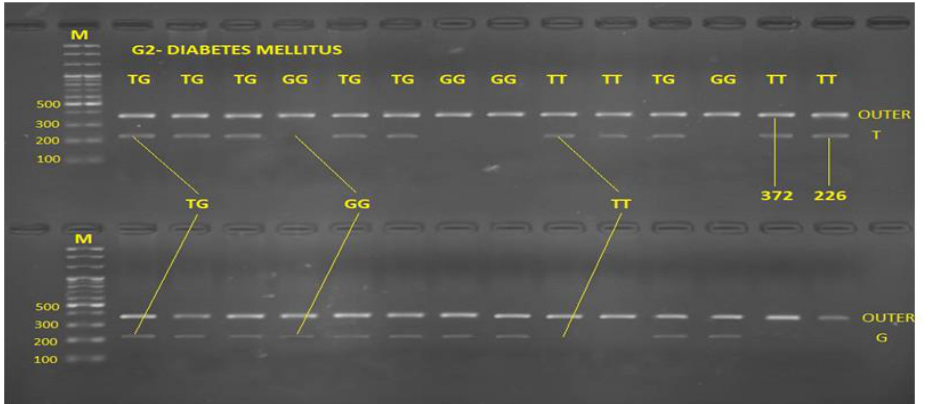
Fig. 2. Gel electrophoresis of ADIPOQ (rs 2241766) gene polymorphism amplified with a specific pair of primers using conventional PCR for T2DM group (G2). M: DNA ladder (100-3000 bp). The PCR products were stained with safe stain dye. homozygous TT genotypes (372 and 226 bp) of FT; heterozygous TG genotypes (372, 226, and 226 bp) of FT+FG; homozygous GG genotypes (226 bp) of FG. The amplification